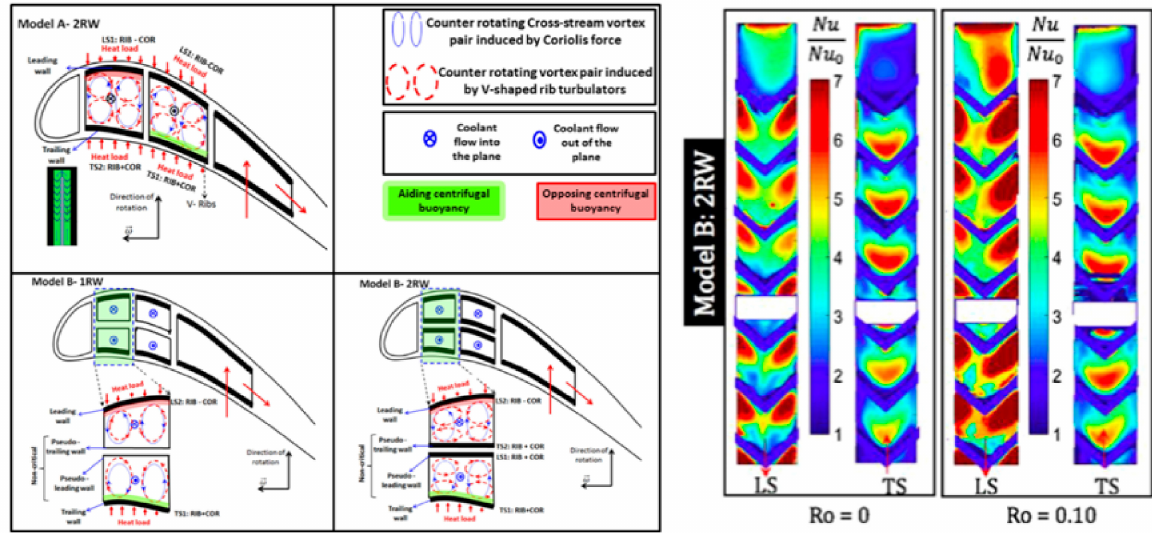
Figure 17. Novel cooling configurations utilizing rotation in favor of heat transfer enhancement on both leading and trailing sides [16]. Reprint with permission from Elsevier (order number